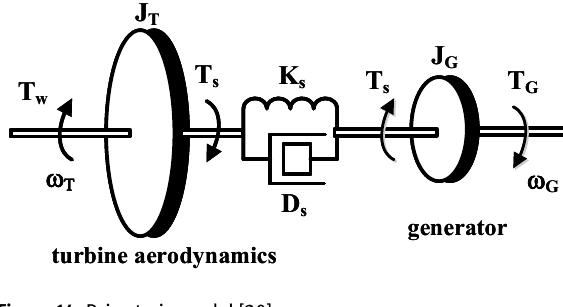
Figure 14: Drive train model [20].